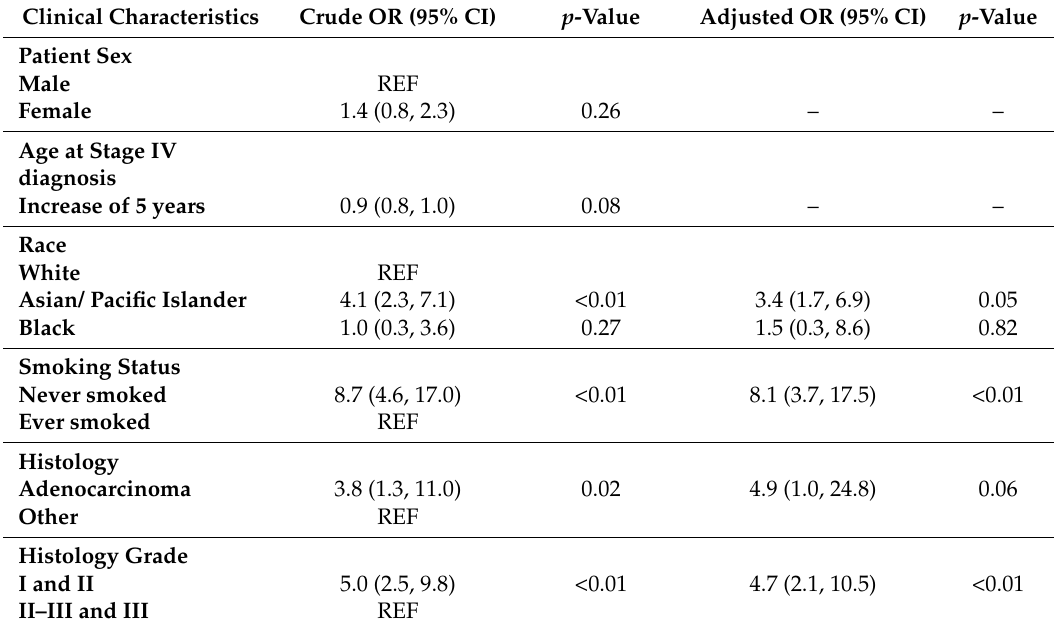
Table 2. Logistic regression of variables predicting of positive EGFR